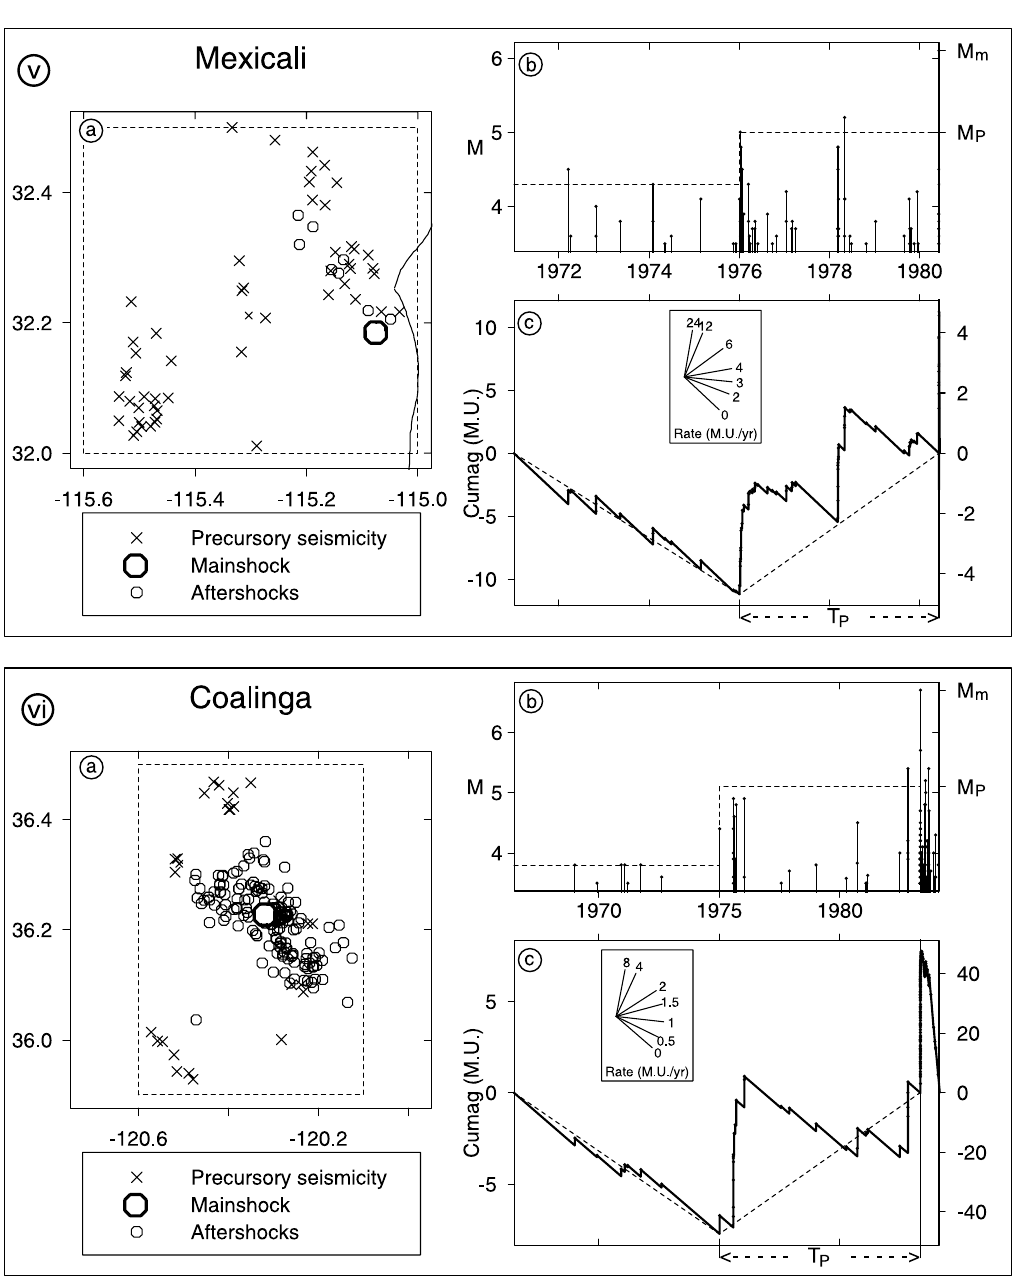
Fig. 3v,vi. (cid:115) -phenomenon: data and interpretation for major earthquakes at (v) Mexicali and (vi) Coalinga. For explanation see caption fig.